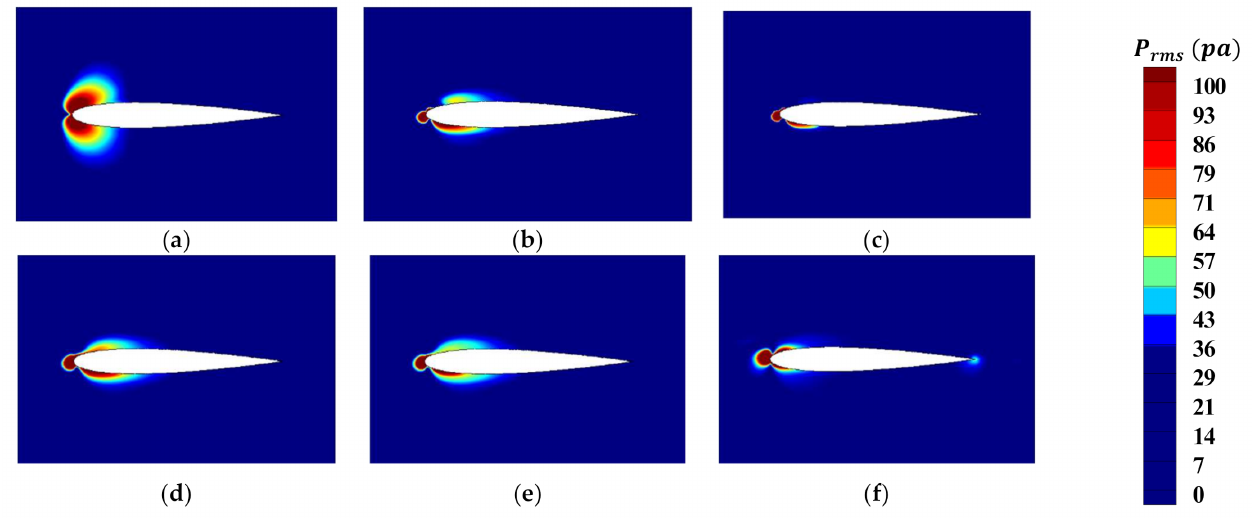
Figure 16. Distribution of RMS pressure variations after applying control: ( a ) A/C = 0, ( b ) A/C = 0.02, ( c ) A/C = 0.04, ( d ) A/C = 0.06, ( e ) A/C = 0.08, ( f ) A/C = 0.1. It should be noted that the asymmetry of the average pressure distribution is due to the displacement movement and the asymmetry of the center of the cylinder and the airfoil in the direction perpendicular to the flow (2